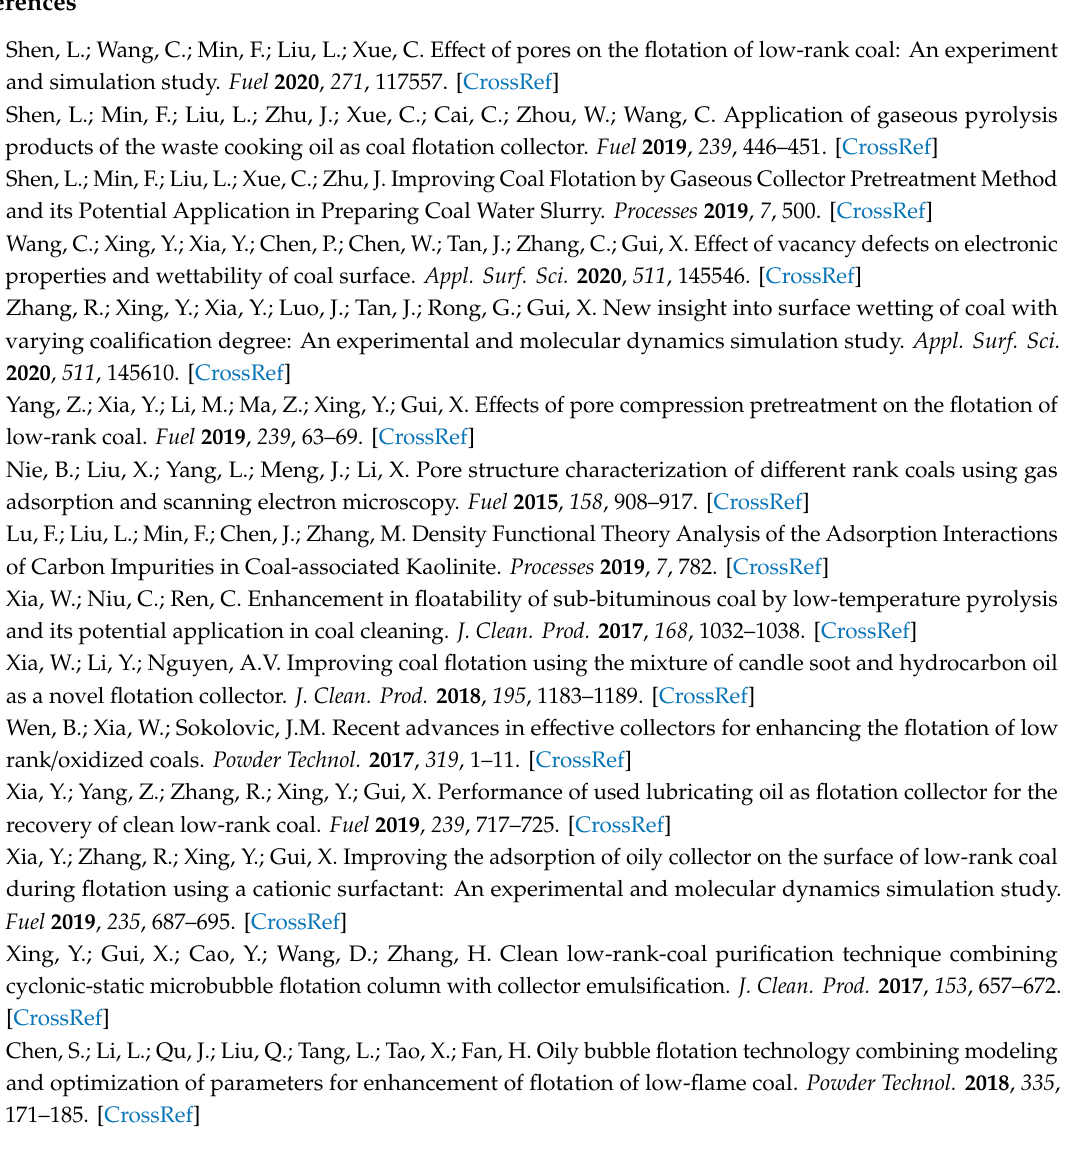
Figure S1: Wender coal molecule (The numbers are the Mulliken charges of each